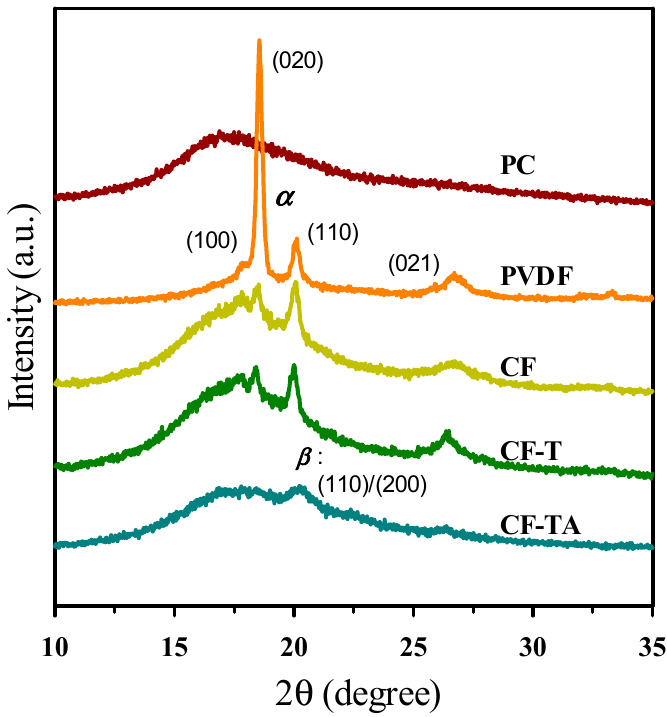
Figure 3. XRD patterns of 5 °C/min cooled representative samples.